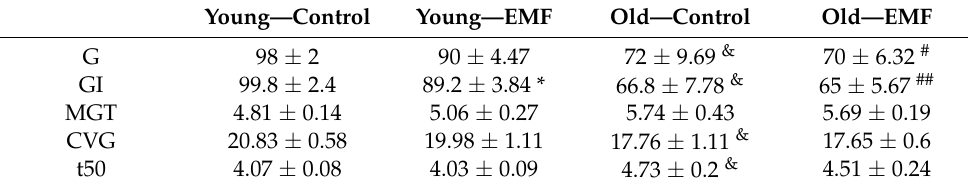
Table 2. The effects of EMF on germination parameters of field bean seeds cultivated for 14 days in pots under long-day